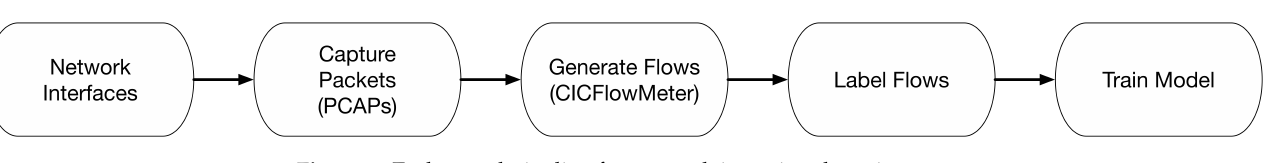
Figure 2. End-to-end pipeline for network intrusion detection